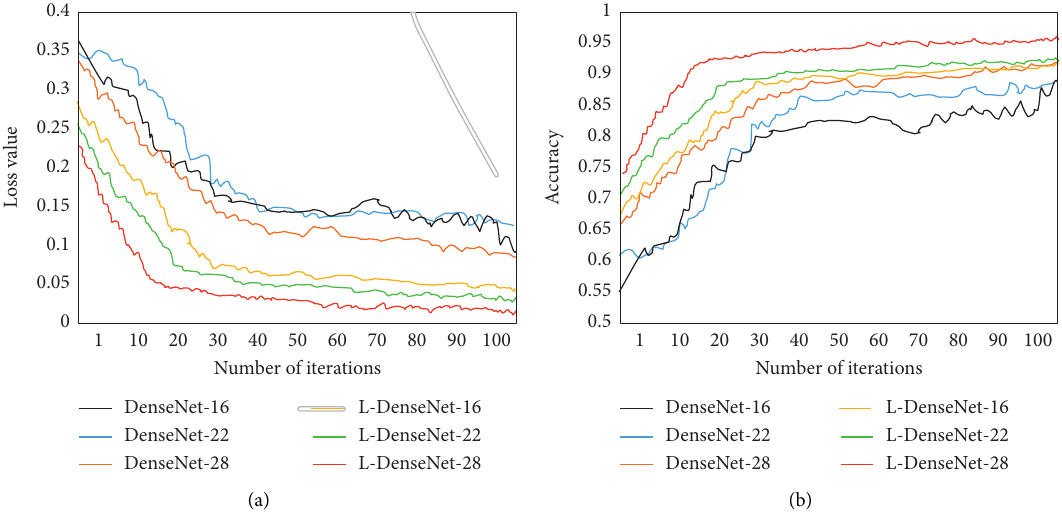
Figure 6: The relationship between the cross-entropy loss, classification accuracy of each model, and the number of iterations during the training process. (a) The relationship between cross-entropy loss. (b) The relationship between classification accuracy.